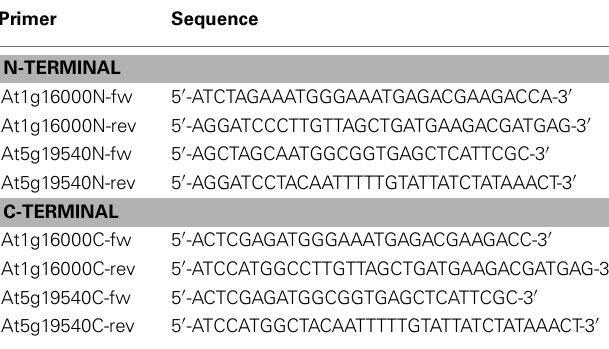
Table 2 | Primers used for producing N-/C-terminal GFP fusion constructs together with their sequences.